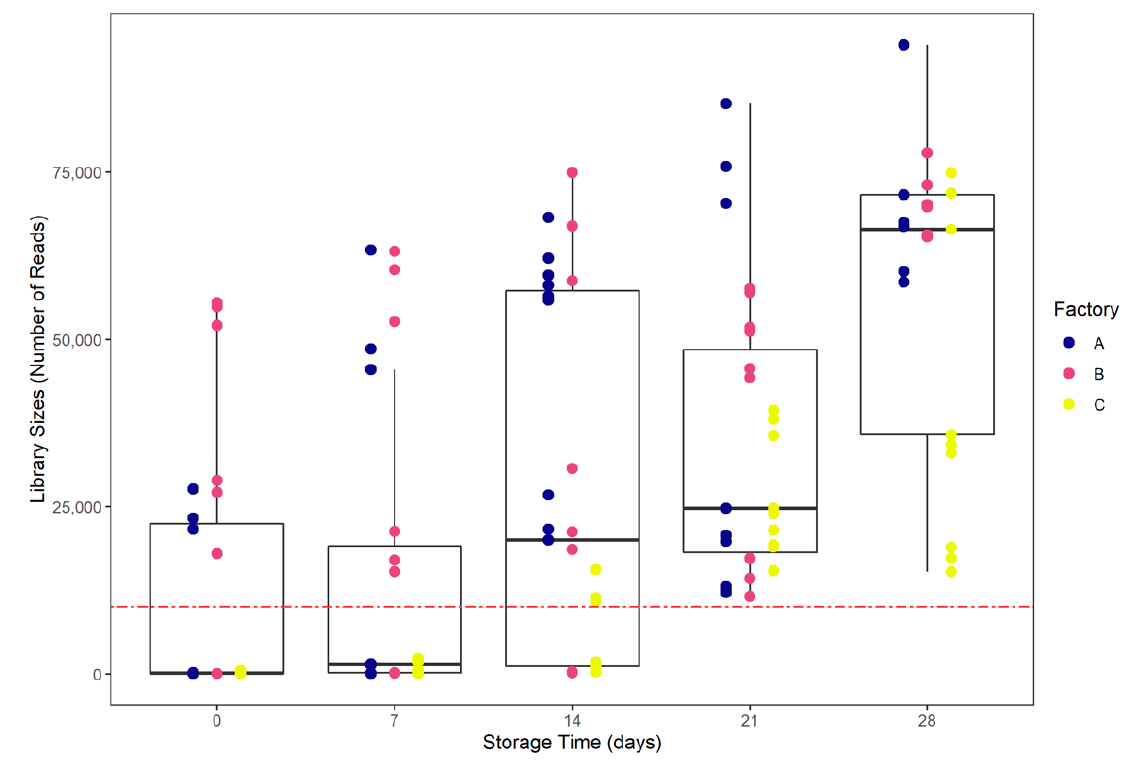
Figure 3. Library sizes distribution according to storage date. The red-dashed line represents a 10,000 reads threshold. The relative abundances at the genus level are represented in Figure 4.